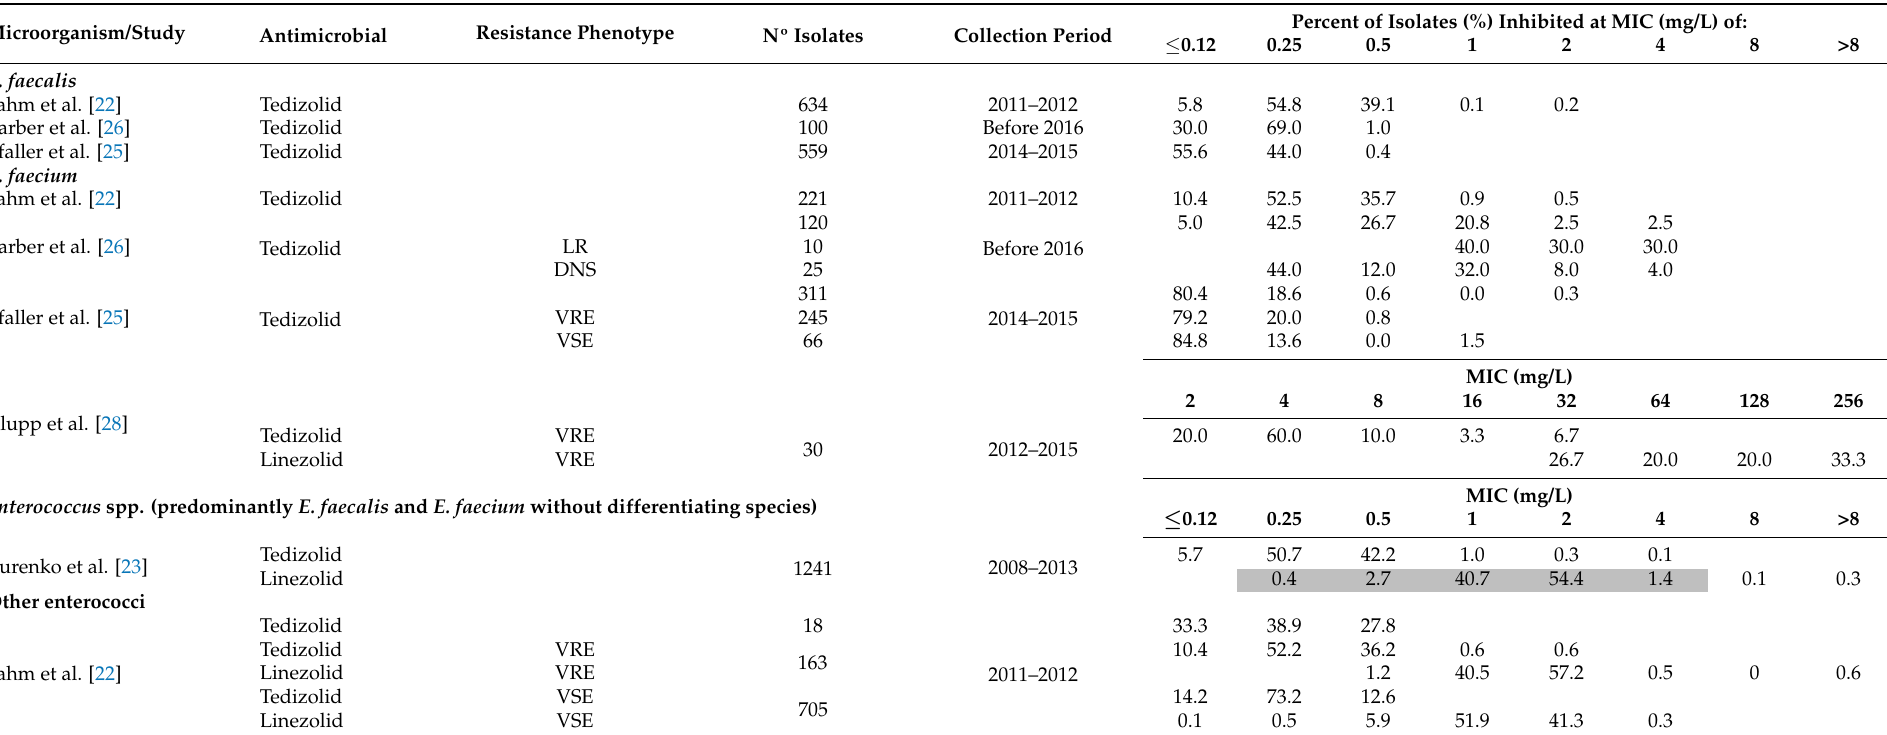
Table 3. Resistance phenotype, number of isolates, collection period, and antimicrobial activity of enterococci for tedizolid and linezolid. Microorganism/Study